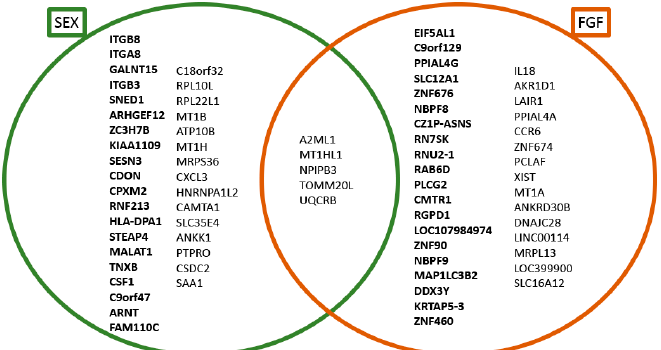
Figure 2. Venn diagram of the 40 most significantly regulated genes obtained with “TRAM sex” and “TRAM FGF” single gene level analysis. Genes in bold are those overexpressed in male (diagram “SEX”) or in cell supplemented with FGF (diagram “FGF”), while genes written not in bold are the underexpressed